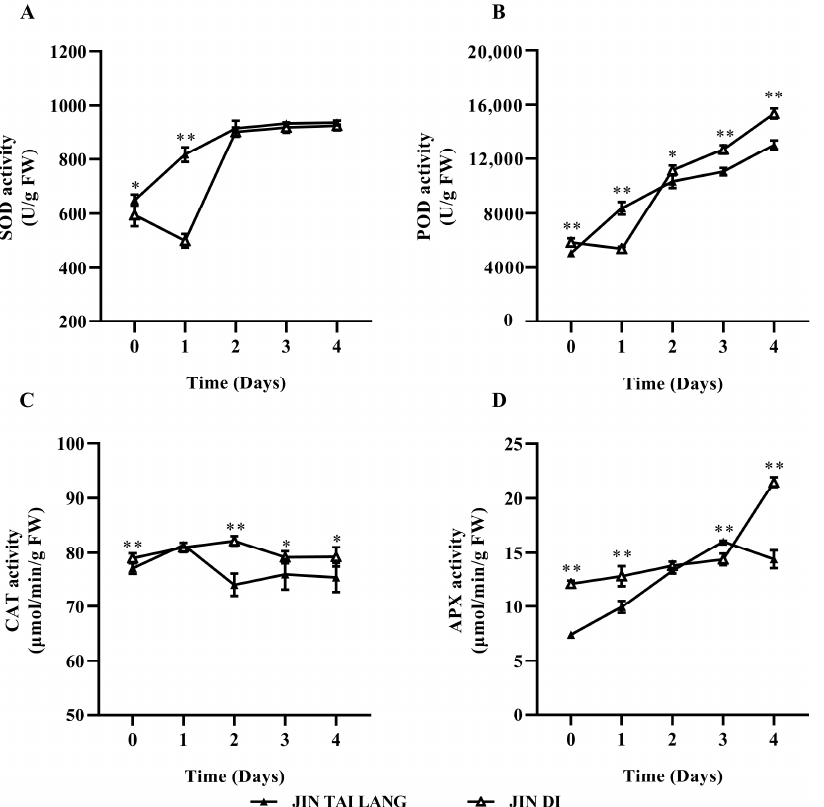
Figure 2. Effects of HTH treatment on antioxidant enzyme activities in different melon seedlings. ( A ), superoxide dismutase (SOD) activity; ( B ), peroxidase (POD) activity; ( C ), catalase (CAT) activity; ( D ), ascorbate peroxidase (APX) activity. Significant different levels of antioxidant enzymes in melon seedlings under different days of stress: * ( p < 0.05), ** ( p < 0.01). Values are represented as the means ± SD ( n =